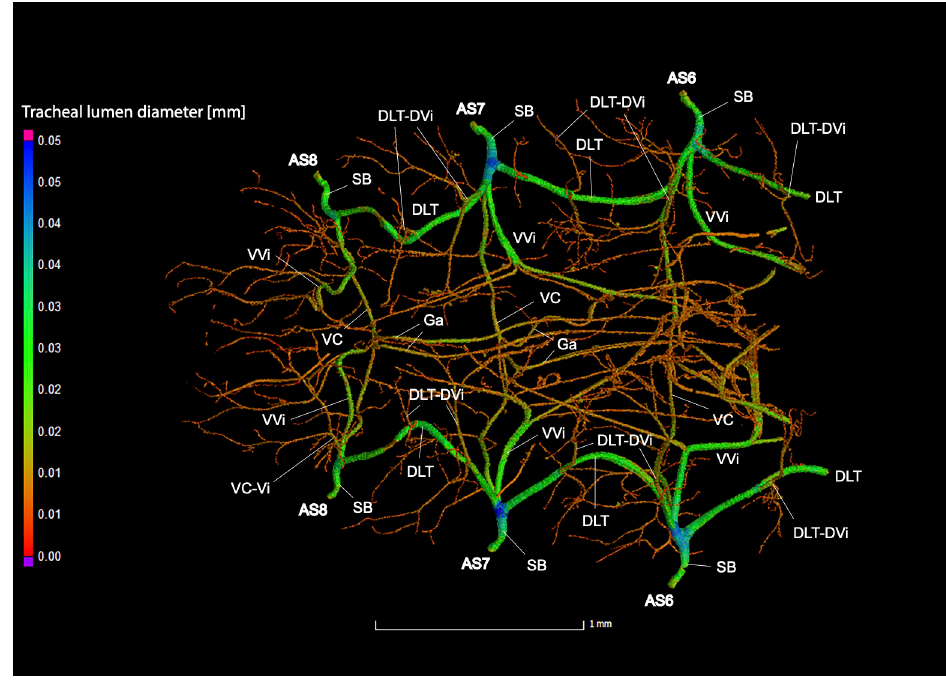
Fig 1. Dorsal view of the abdominal tracheal system in Photinus pyralis final instar larva.